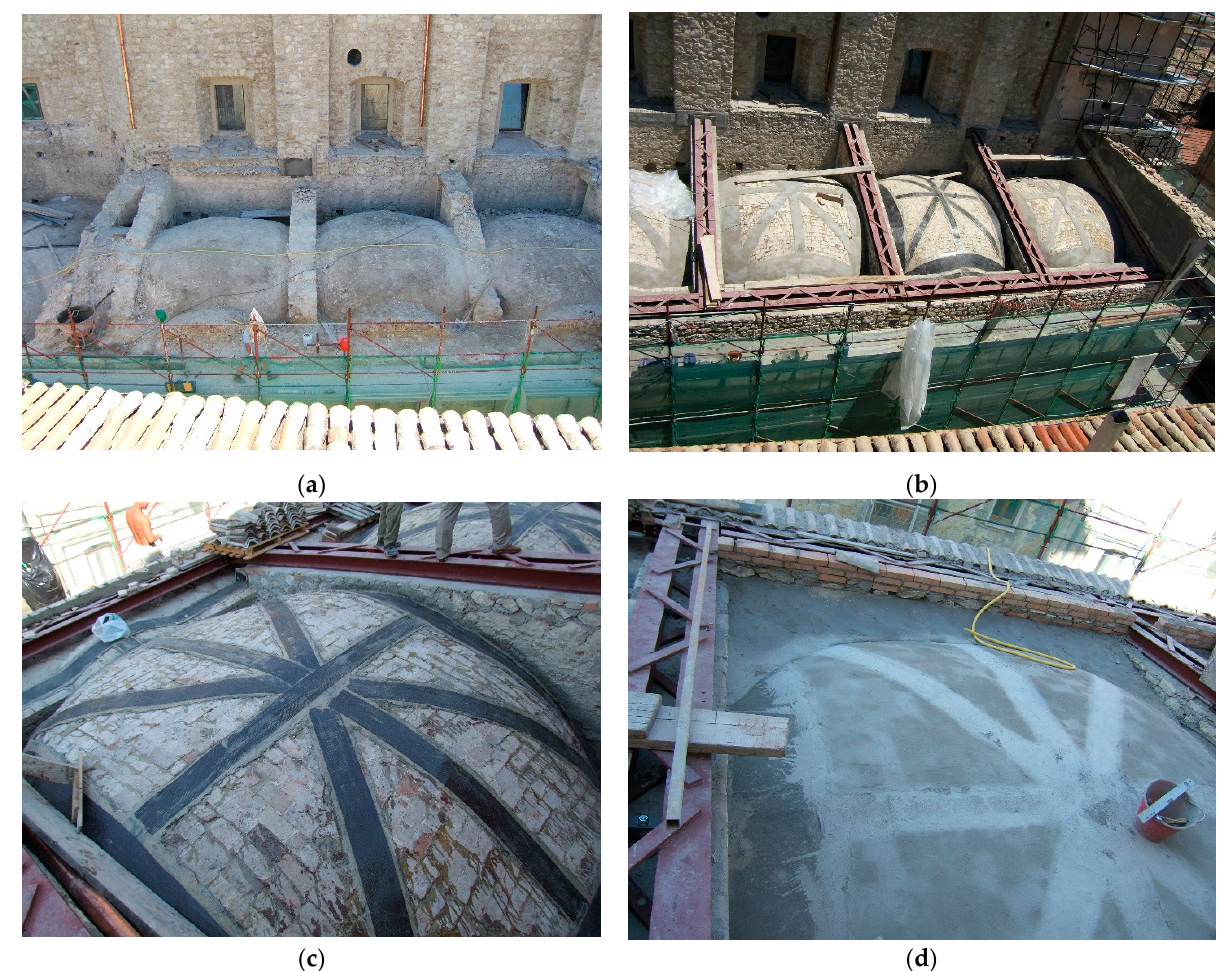
Figure 2. Composite strengthening of bohemian vaults with lunettes: ( a ) before the intervention; ( b ) application of composite strips; ( c ) detail of the composite reinforcement; ( d ) detail of the completed intervention.